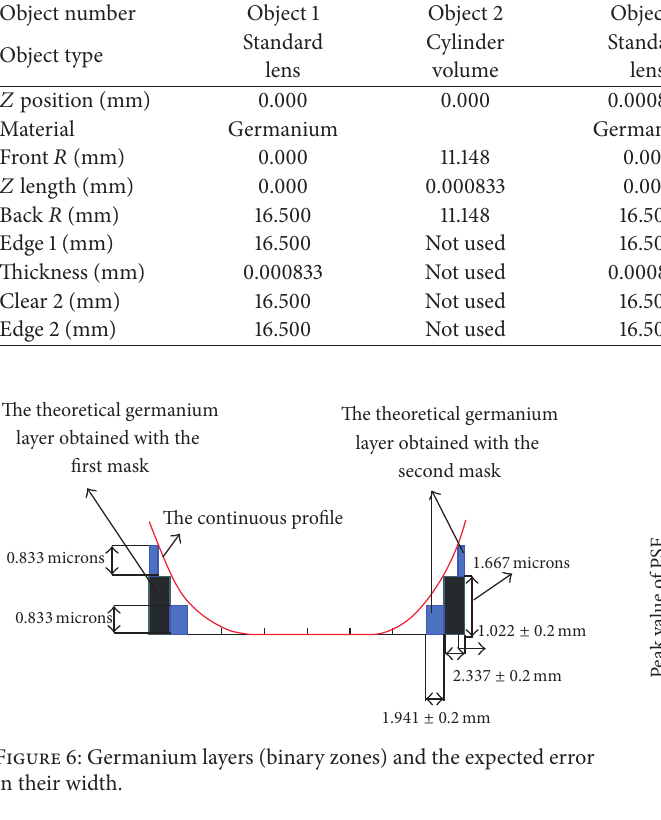
Table 5: Data in the nonsequential component editor.